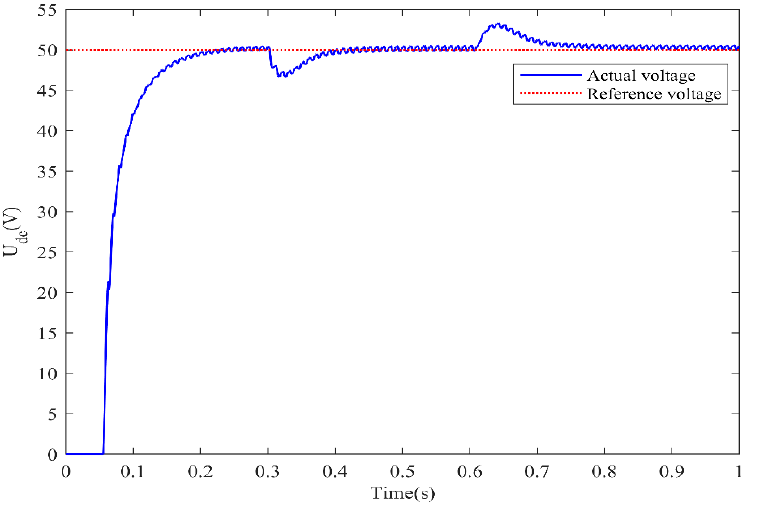
Figure 14. DC side voltage curve.